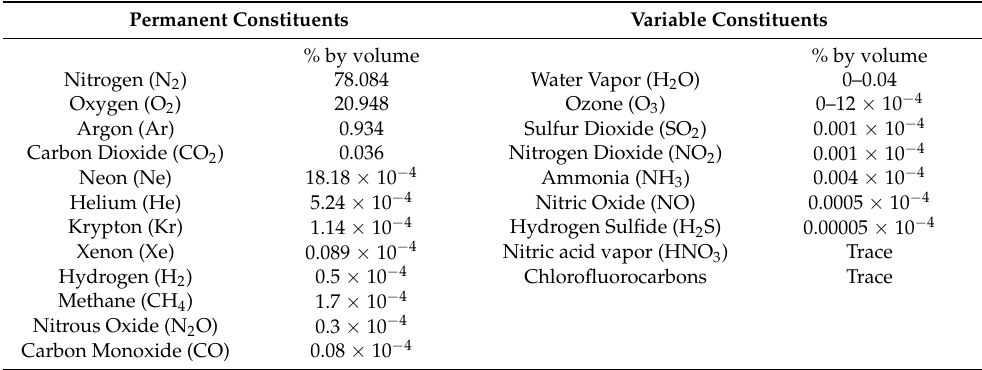
Table 2. Atmospheric molecular composition. Adapted from [27], reproduced with permission.